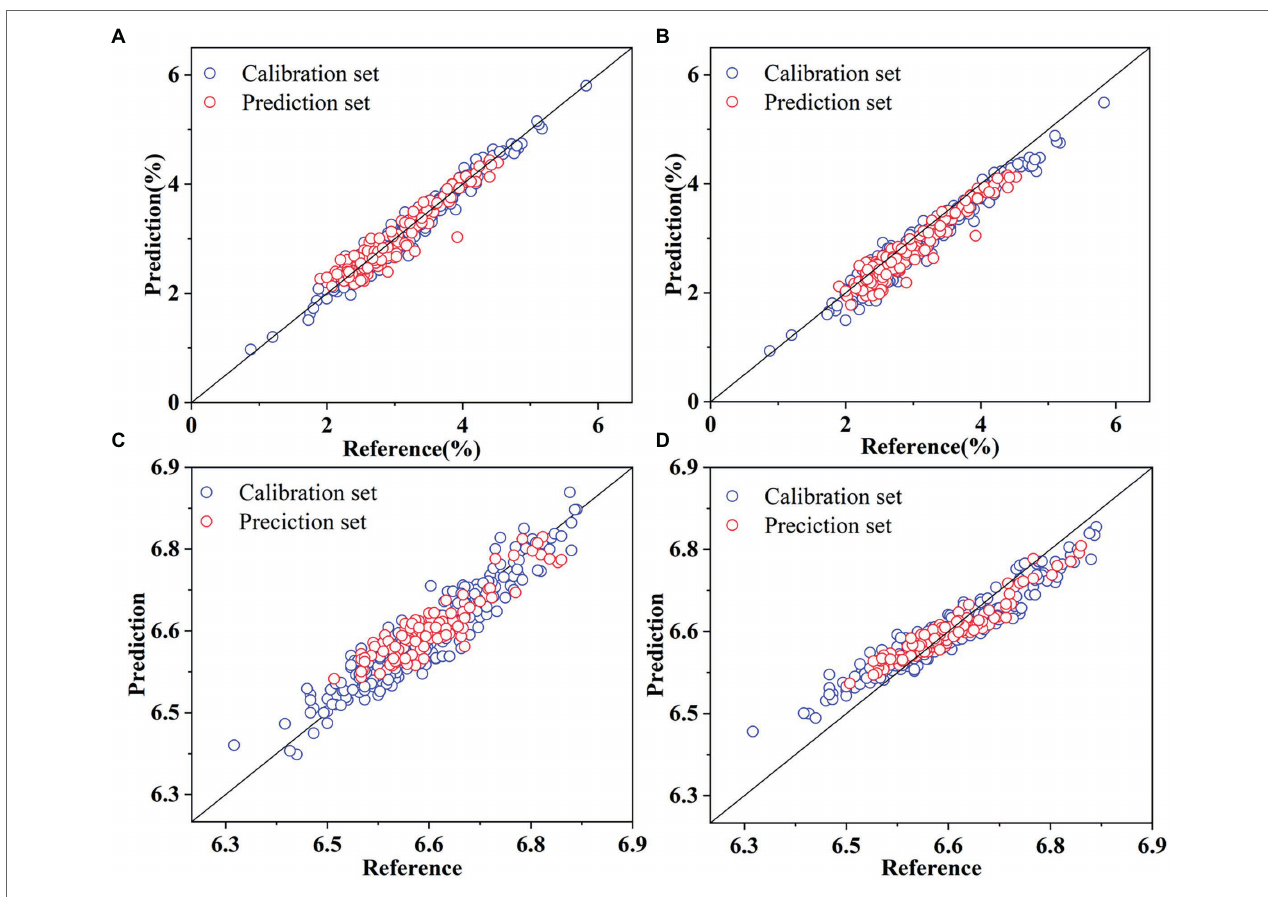
FIGURE 7 | Prediction of SSC based on Deep2D (A) and DeepFC (B) , and pH based on Deep2D (C) and DeepFC (D)